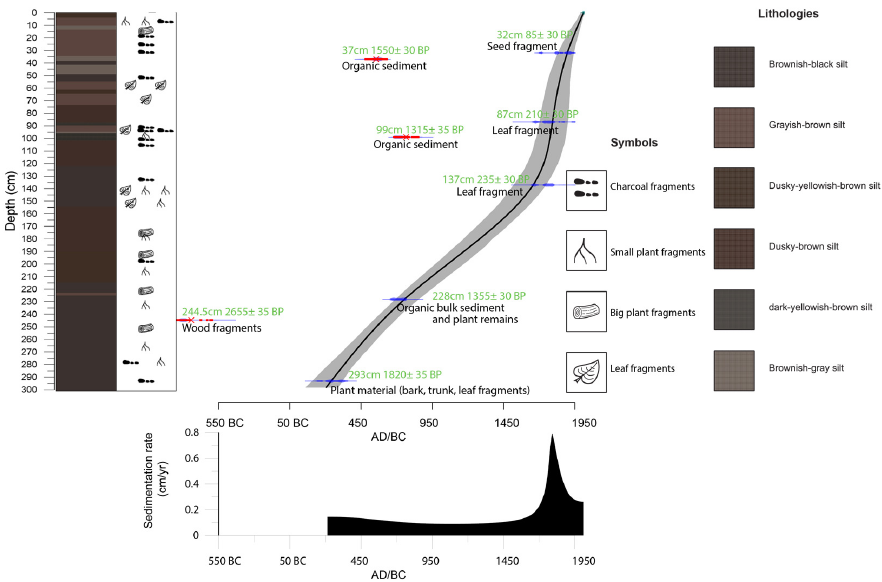
Figure 2. The lithology and age–depth model of the DK core. Red points represent the outliers. Table 1. A list of the radiocarbon dates from the DK